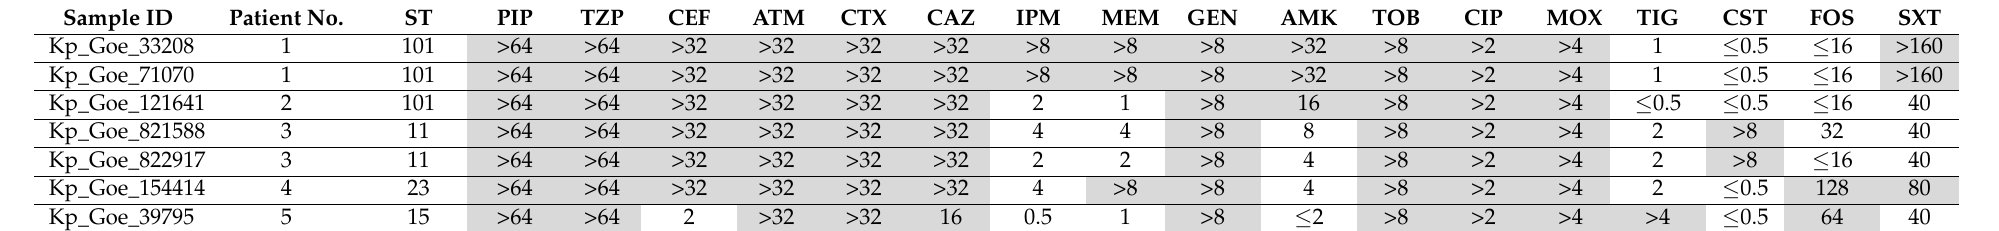
Table 2. Antibiotic susceptibilities of seven OXA-48 producing Klebsiella pneumoniae isolates. Sample